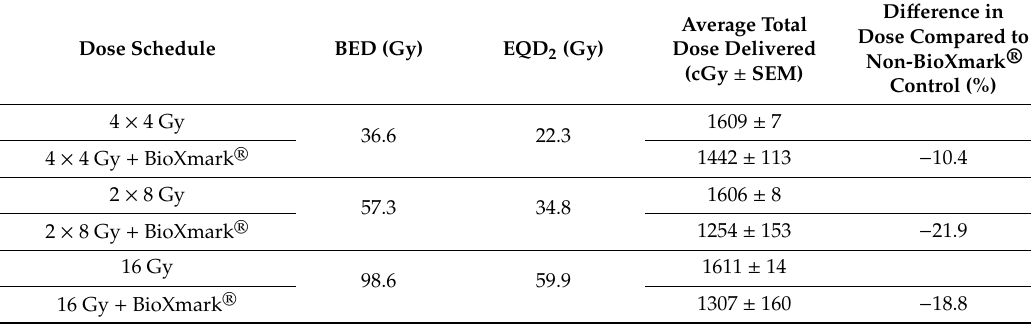
Di ff erence in Average Total Dose Compared to Dose Delivered Non-BioXmark ® (cGy ± SEM) Control (%)